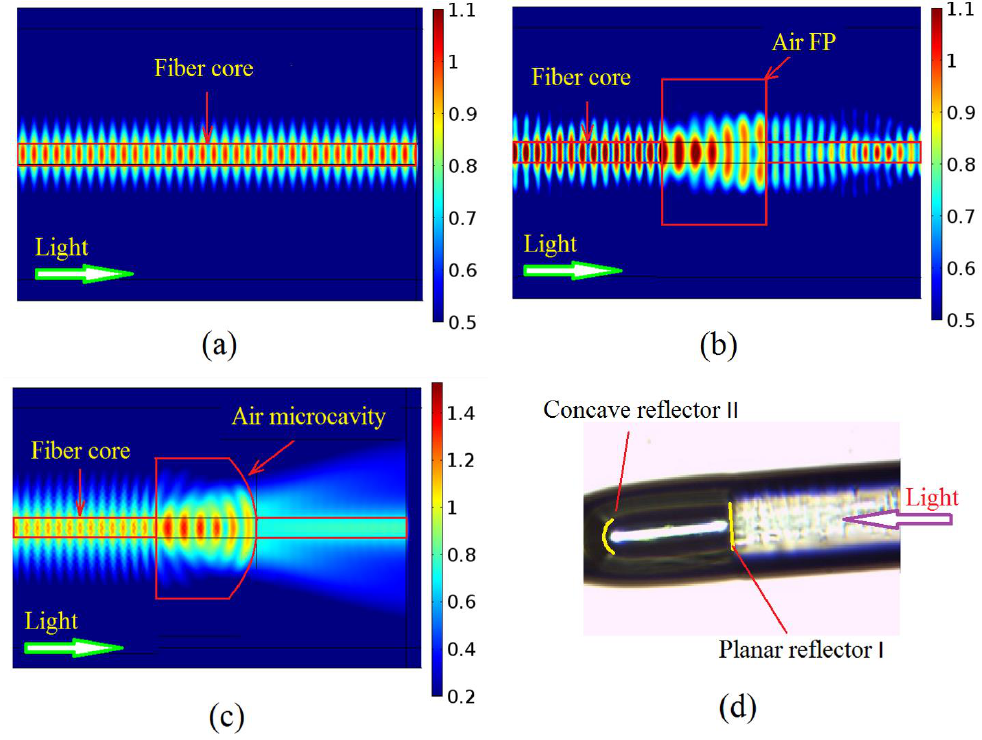
Figure 2. Mode field distribution base on FEM. ( a ) Mode field distribution of SMF. ( b ) Mode field distribution of F-P cavity. ( c ) Mode field distribution of F-P cavity with concave reflector. ( d ) Microscope image of F-P cavity with concave reflector. (SMF: Single mode fiber; the refractive index of the core is 1.4679; the refractive index of the cladding is 1.4613; the refractive index of air is 1; the incident light wavelength is 1550 nm.)